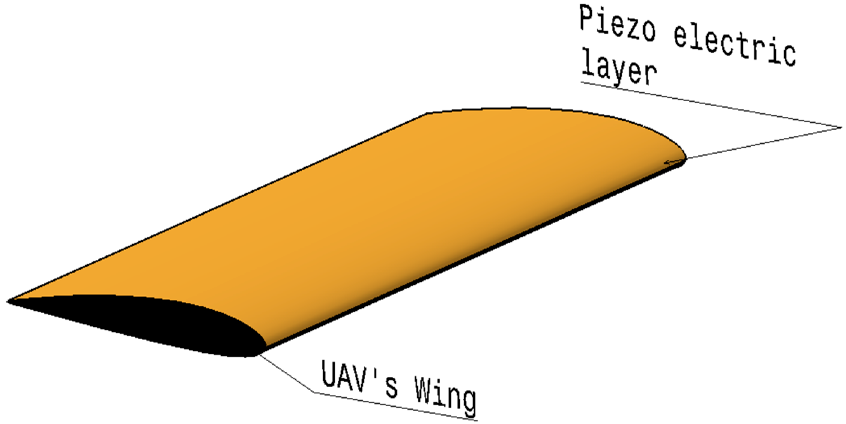
Figure 39. A typical view of a UAV wing with piezoelectric patch.